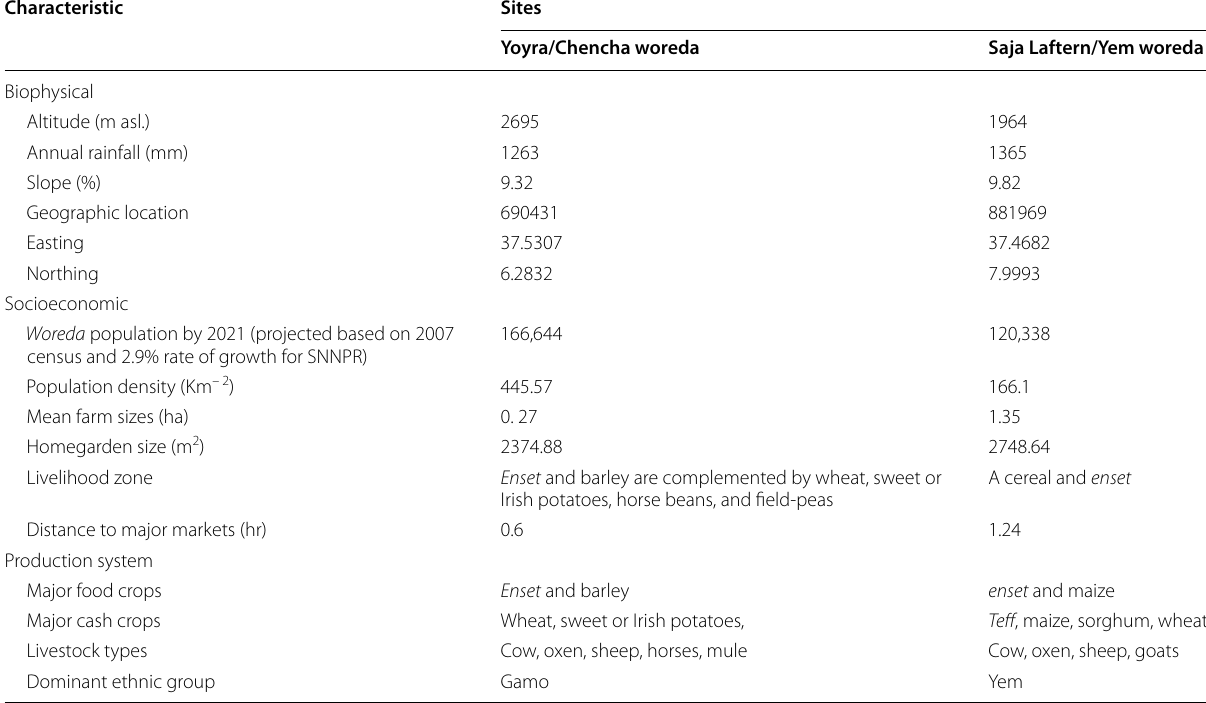
Table 1 Main characteristic of sampled homegarden agroforestry sites in southern and southwestern Ethiopia Characteristic